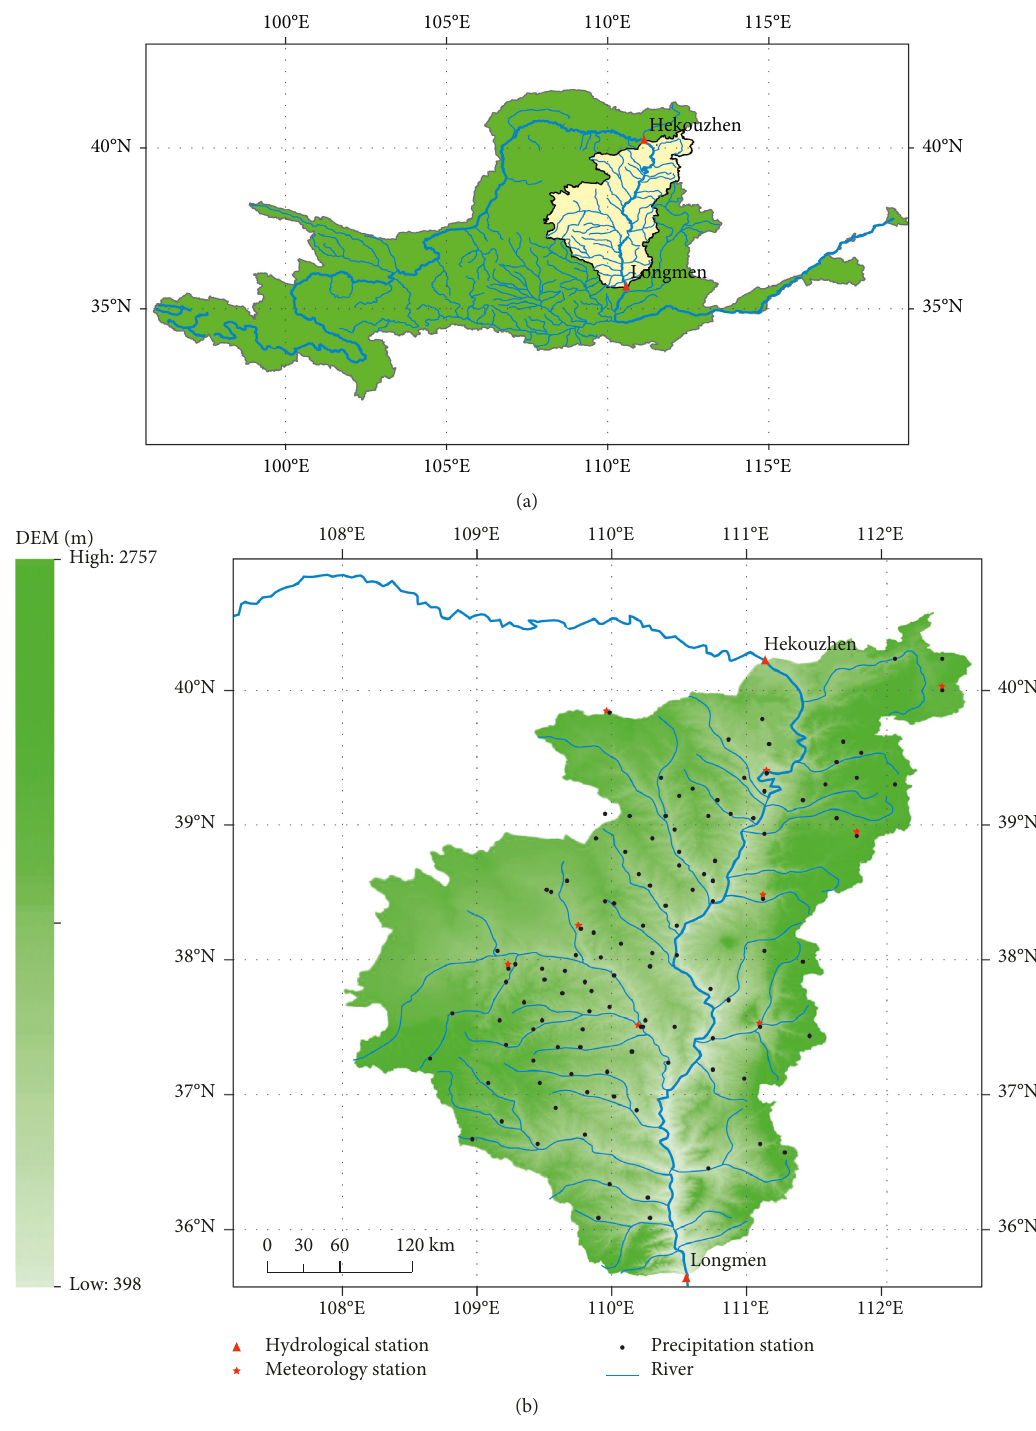
Figure 1: Sketch map of the study